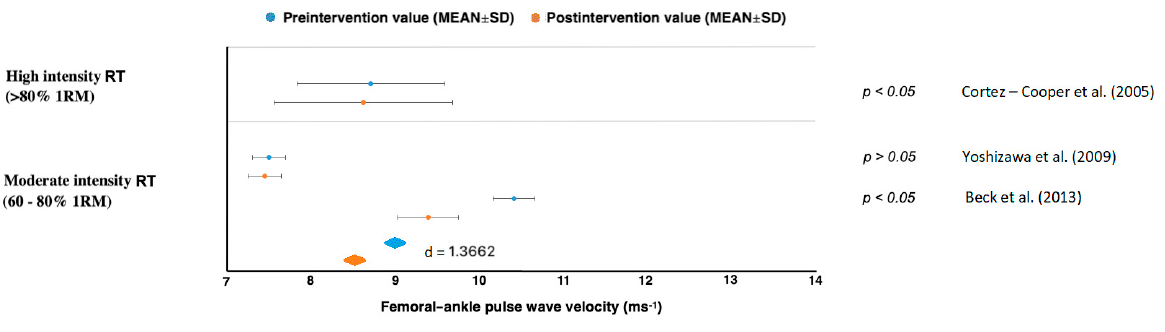
Figure 5. Brachial–ankle pulse wave velocity changes. a upper limb training group, b lower limb training group, c group of resistance training with slow lifting and quick lowering. When a long-term RT was applied at low intensity, AS and PWV improved in five studies [45,52–54,59], and there was no report of a PWV increase in any types of measure- ment. The rest of the studies evaluated the effect of low intensity whole-body vibration training on special platforms [57,58,60,61]. Figueroa et al. [57,61,62] reported improve- ments in AS in his studies, which were subsequently confirmed by Lai et al. [53]. When pre and post differences between treatment and control groups were compared, we got values with high effect sizes for femoral–ankle PWV ( d = 1.3662) and brachial–ankle ( d = 1.0162) [45,51–54,60,61,63,64]. From those results, it can be clearly stated that a low-inten- sity RT (<60% 1RM) reduced AS in all cases regardless of femoral–ankle or carotid–femo- ral measurement (Figures 2–5). 4. Discussion Because physical activity protects against CVD [12,62,65,66], AE has been suggested as a nonpharmacological treatment to improve cardiovascular function in both younger [64,67] and older individuals [68,69]. The results of this study showed that the same gen- eral recommendation is relevant for long-term RT; therefore, it should be recommended as an important part of a complex exercise program, which is what the American College of Sports Medicine has done [70], especially concerning RT in combination with aerobic and whole-body vibration interventions. Long-term RT have favorable effects on muscu- lar power and strength, blood pressure, and muscle function [71] as well as for detailed